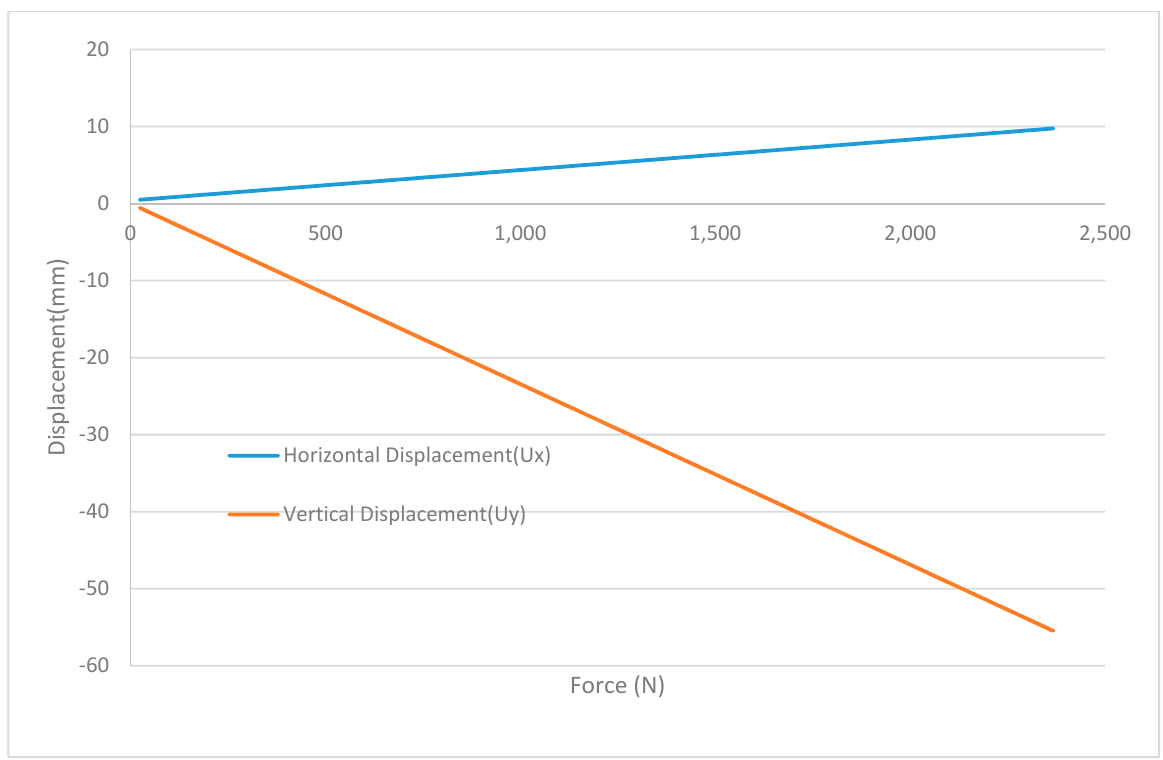
Figure 22. Horizontal and vertical displacements at node 20, element 1126 with coordinate details: ( x = 0, y = 0.25, z = − 4) and 50% FA.